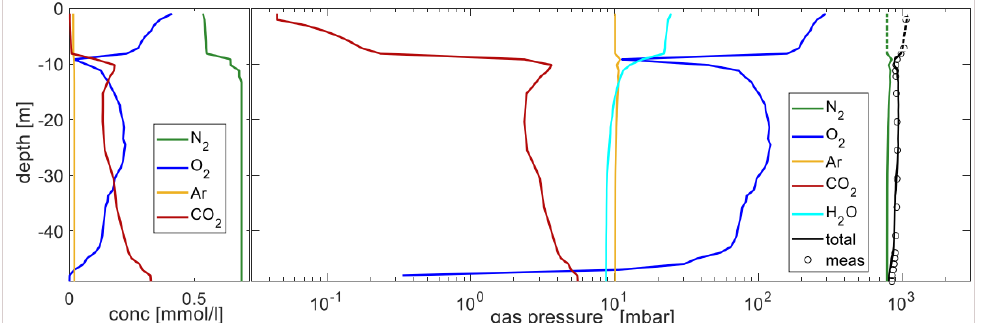
Figure 3. Left panel: concentration of gases in Arendsee on 16 August 2017: right panel: Gas pressures. Oxygen and carbon dioxide gas pressures were measured, while nitrogen and argon were modelled (see text), whereas vapor pressure was calculated from a temperature profile; total gas pressure was calculated from adding the partial pressures of displayed volatile substances and drawn with directly measured total gas pressure from the CO 2 probe (symbols). Broken lines (for epilimnion values of N 2 and total gas pressure) do not represent the real